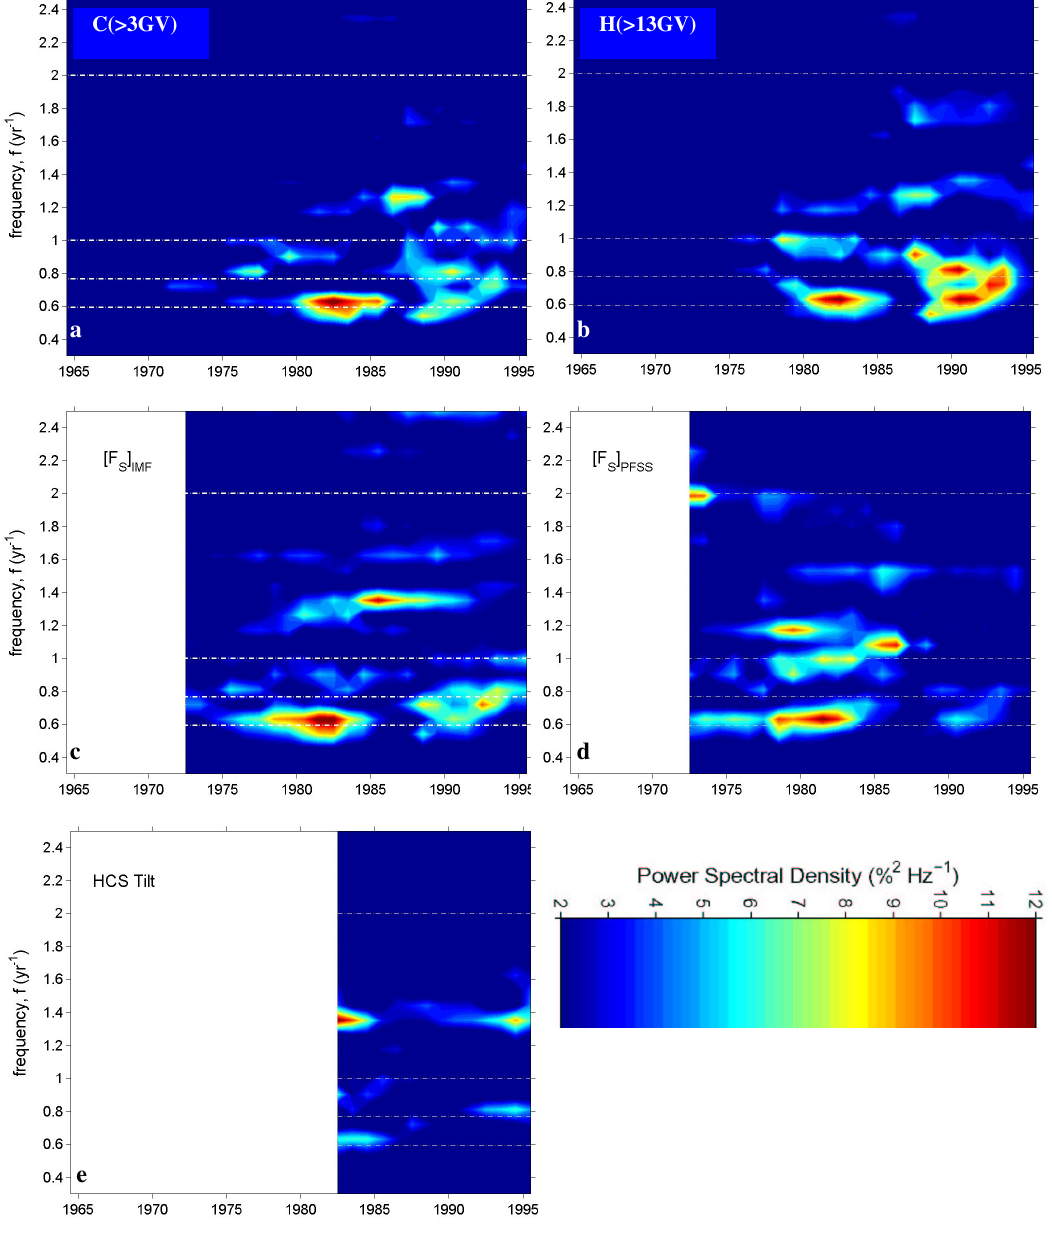
Fig. 4. Spectrograms showing contours of power spectral density as a function of date and frequency, f . The dashed white lines in each panel show periods of 0.5, 1.0, 1.33 and 1.68 years. Power spectra are computed for 11-yr periods, centred on the dates shown on the horizontal axes. Plots are for: (a) Climax neutron monitor ( > 3GV) counts, C ; (b) Huancayo/Hawaii neutron monitor ( > 13GV) counts, H ; (c) open solar flux deduced from the radial interplanetary magnetic field measured near Earth, [ Fs ] IMF ; (d) open solar flux deduced from photospheric magnetograms by the PFSS method, [ Fs ] PFSS ; and (e) the heliospheric current sheet tilt